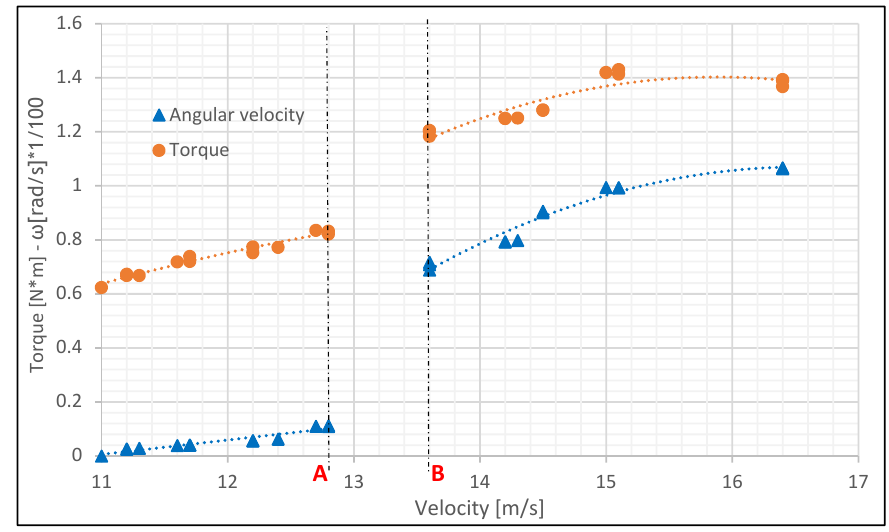
Figure 12. Toque vs Upstream Velocity and Angular Velocity vs Upstream Velocity for 15 ◦ blade pitch